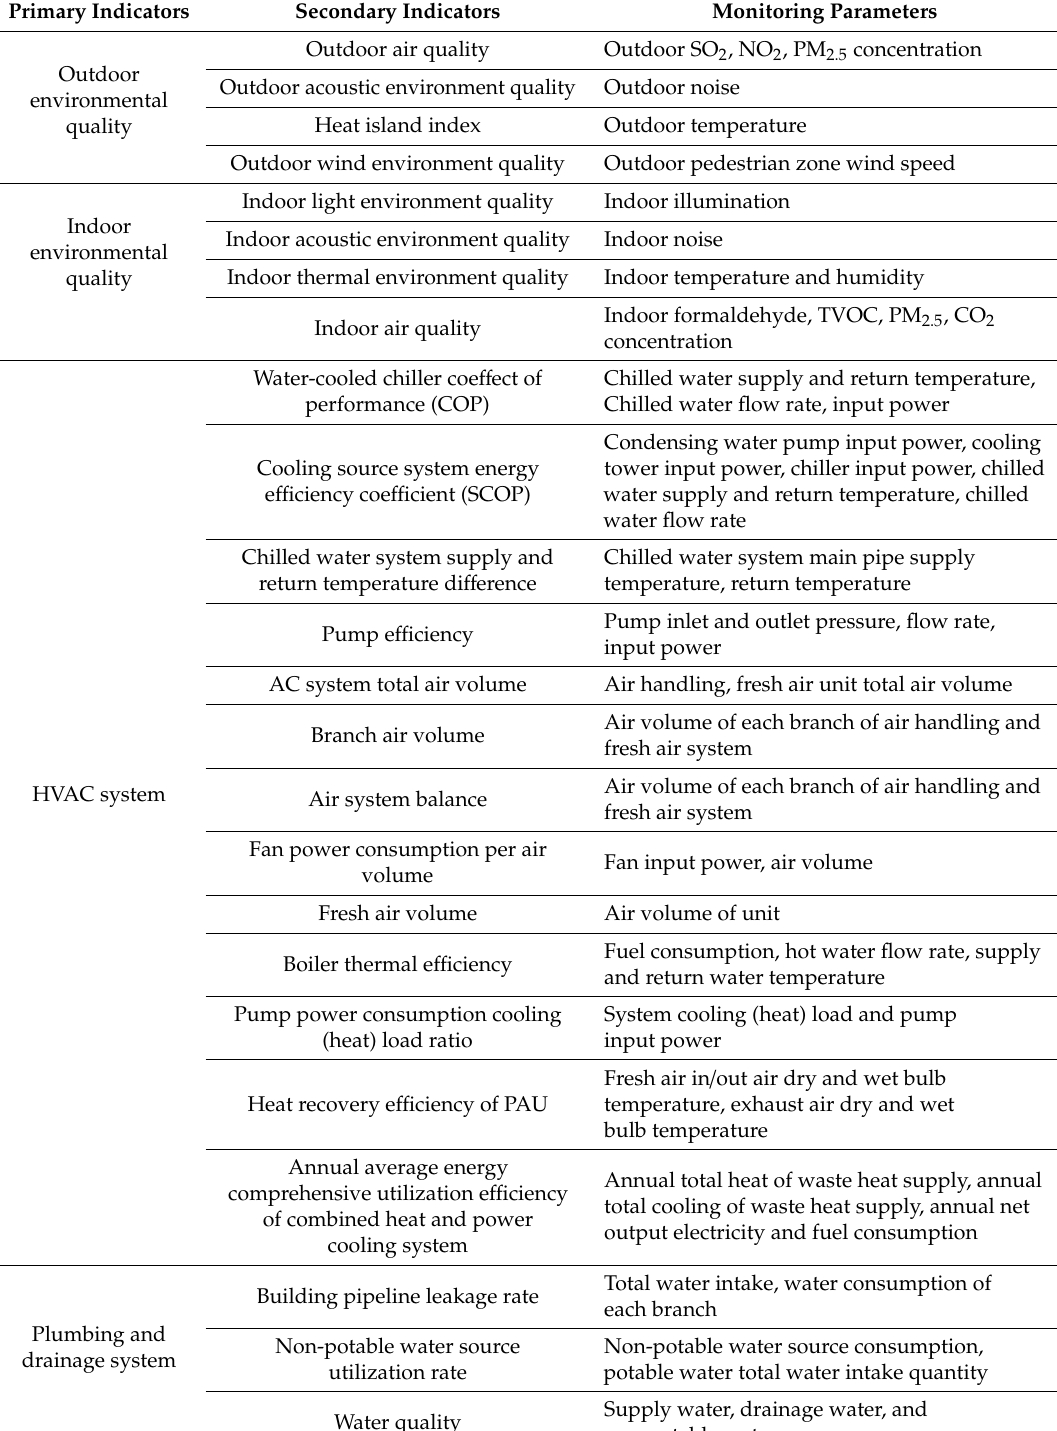
Table 10. Green building operation monitoring indicators library and monitoring